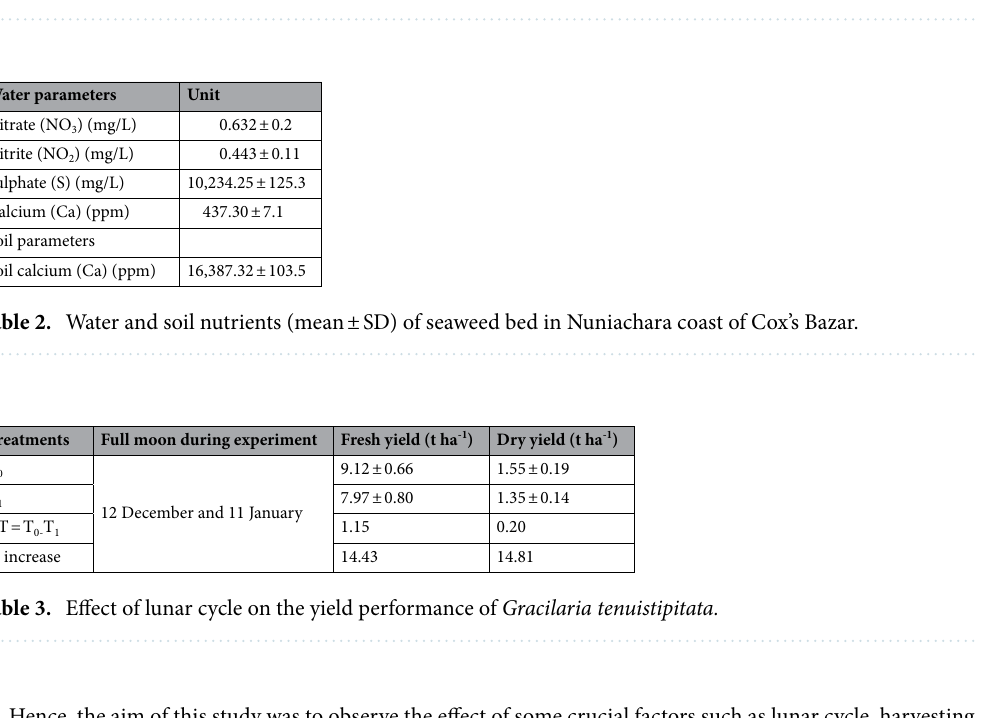
Table 1. Mean values of water quality parameters during experimental period of 60 days.